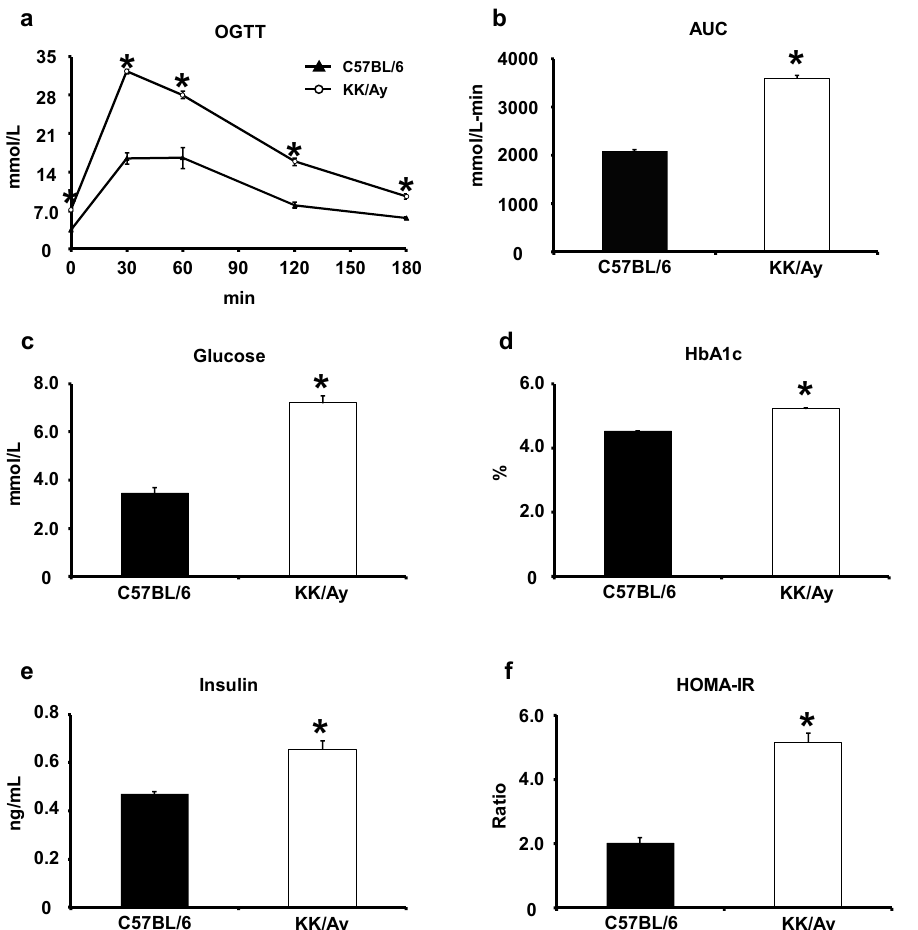
Figure 1. Comparison of biochemical parameters in C57BL/6 and KK/Ay mice. ( a ) An oral glucose tolerance test (OGTT) was performed ( n = 5–6). ( b ) The AUC was calculated using the trapezoid rule ( n = 5–6). ( c ) The fasting glucose was measured using commercial kits ( n = 5–6). ( d ) The fasting HbA1c was measured by Oriental Yeast CO., Ltd. ( n = 5–6). ( e , f ) Insulin levels and HOMA-IR were measured using commercial kits ( n = 5–6). Values are presented as the mean ± SE. * p < 0.05 vs. C57BL/6 group.